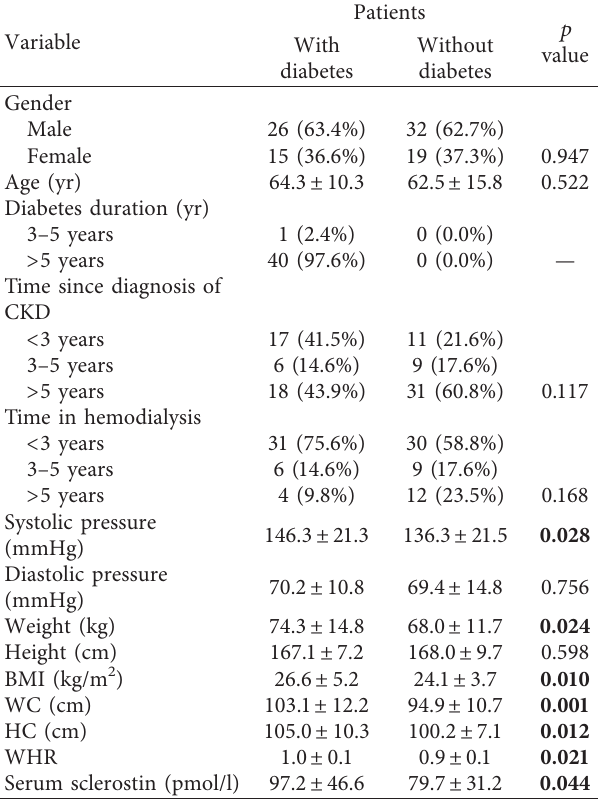
Table 1: Clinical characteristics of the study